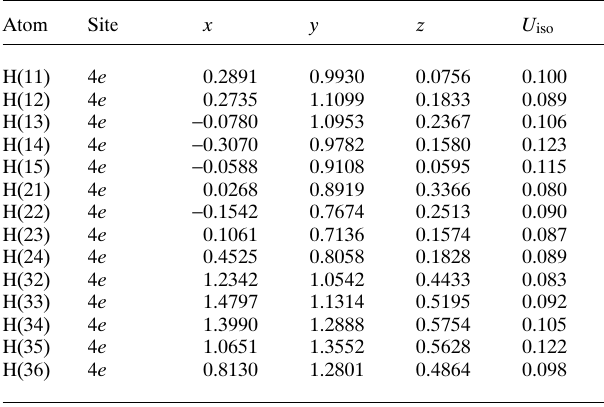
Table 2. Atomic coordinates and displacement parameters (in Å 2 )